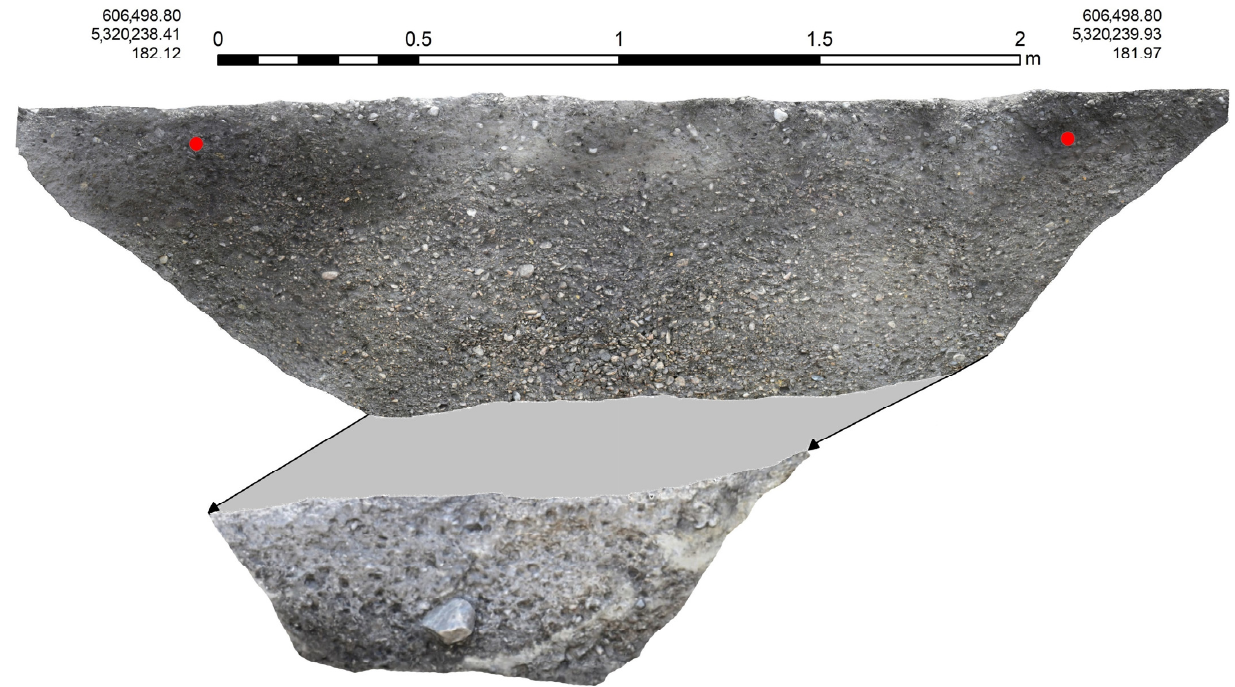
Figure 11. Photographic documentation of the profile of the outer ditch at KGA Velm. Due to safety reasons, the ditch was excavated in two steps, and the gray area indicates this interruption. The red dots indicate the position of coordinates.